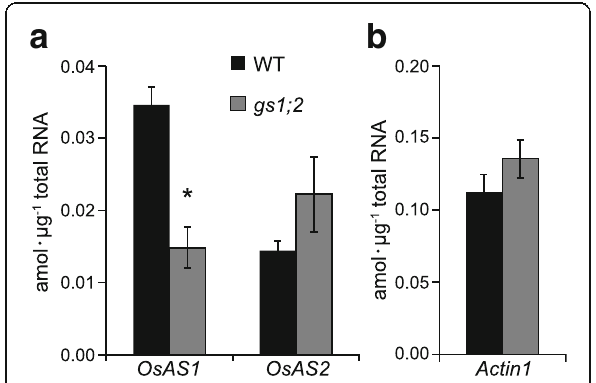
Fig. 1 qPCR analysis of OsASs in the basal portions of wild-type and gs1;2 mutant shoots. qPCR analysis of OsAS1 and OsAS2 genes ( a ) and a control Actin1 ( b ) in the basal portions of shoots of wild-type plants (WT: black column) and gs1;2 mutants ( gs1;2 : grey column) were performed. Rice seedlings were grown hydroponically in the presence of 1 mM NH 4 Cl until the fourth-leaf stage. Mean values with SE of four independent samples are shown. An asterisk denotes a statistically significant difference between wild type and gs1;2 mutants (*, P < 0.05 by Student ’ s t